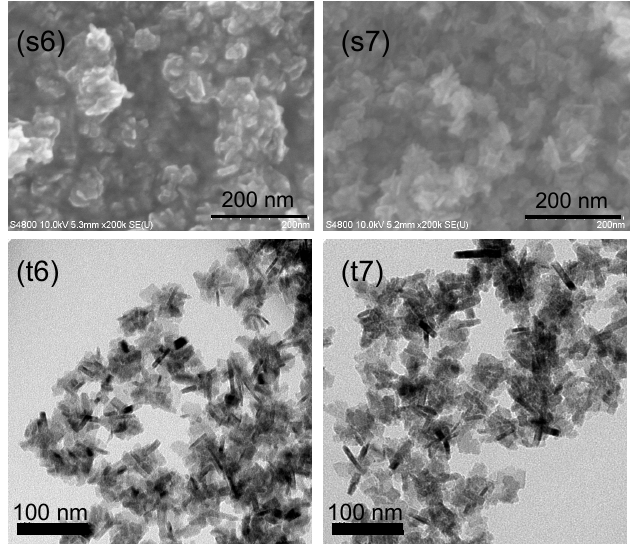
Figure 2. Scanning electron microscopy (SEM) ( s ) and transmission electron microscopy (TEM ( t ) images of the powders prepared from ( 1 ) CuC2; ( 2 ) CuC3; ( 3 ) CuC6; ( 4 ) CuC8; ( 5 ) CuC10; ( 6 ) CuC12; and ( 7 ) CuC14 as starting reagents.